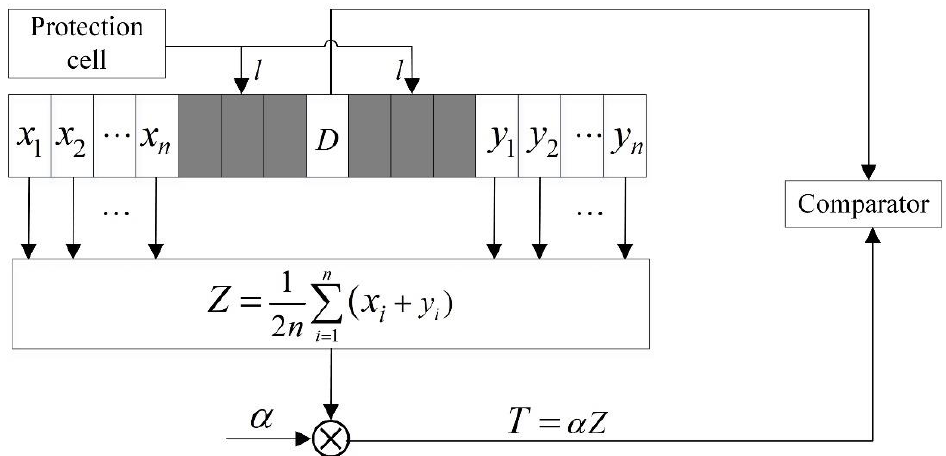
Figure 1. The principle of the CA-CFAR algorithm.